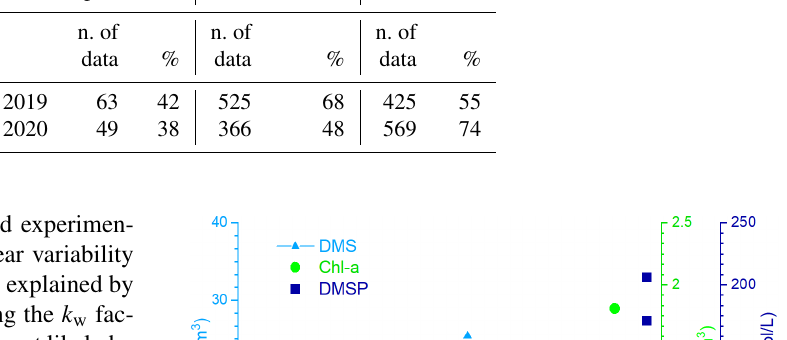
DMS conc. Wind direction > 75th from Wind speed percentile the ice sheet < 10ms − 1 n. of n. of n. of data % data % data %